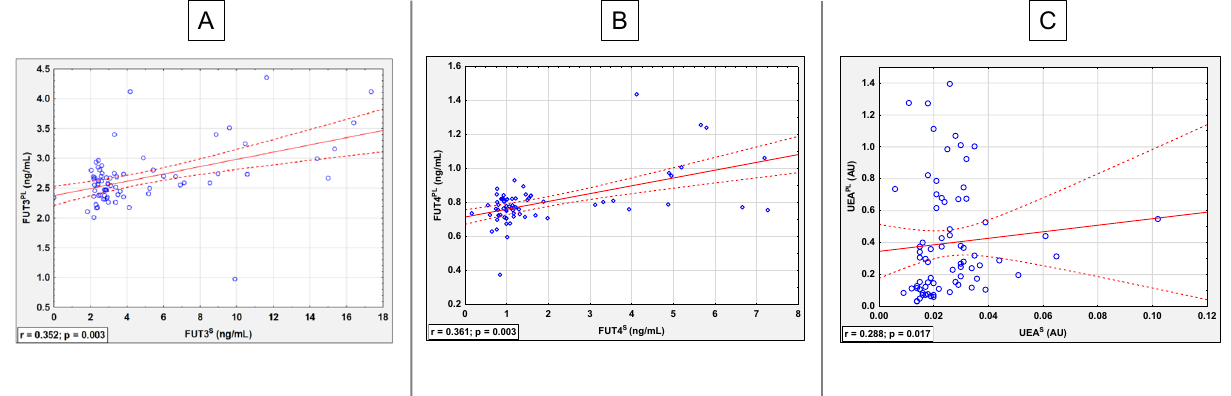
Figure 2. Comparison of glycosylation profile in two biological fluids (seminal plasma and serum) in the study group ( A–C ). FUT3 PL —seminal plasma FUT3 concentration; FUT3 S —serum FUT3 concentration; FUT4 PL — seminal plasma FUT4 concentration; FUT4 S —serum FUT4 concentration; UEA PL —relative reactivity of